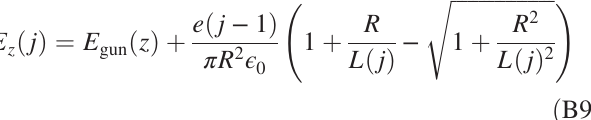
ffiffiffiffiffiffiffiffiffiffiffiffiffiffiffiffiffiffiffi